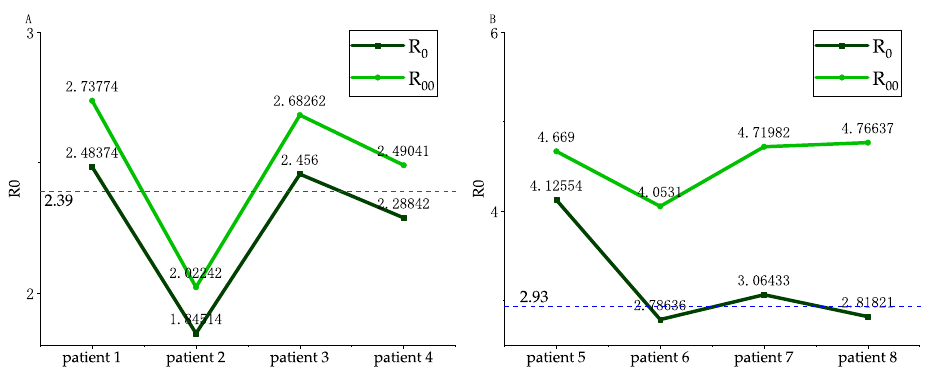
Figure 7. With the basic reproduction number ( R 0 ) and without T cells and antibodies ( R 00 ): ( A ) mild patients; ( B ) severe patients. The red line indicates the boundary between at-risk and mild patients. The blue line indicates the boundary between at-risk and severe patients.